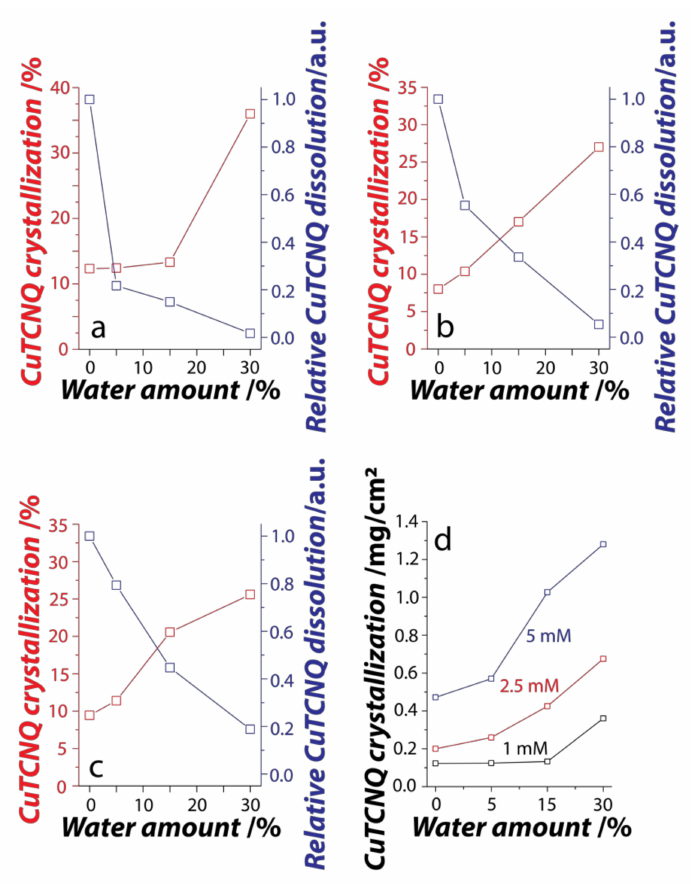
Figure 4. Crystallization and simultaneous co-dissolution of CuTCNQ in Water–DMSO bisolvent. Influence of water on CuTCNQ crystallization and corrosion at ( a ) 1 mM ( b ) 2.5 mM and ( c ) 5 mM TCNQ concentrations; ( d ) CuTCNQ crystallization on the surface of the Cu foil. % CuTCNQ crystallization in ( a – c ) refers to the proportion of TCNQ 0 reactant used during the crystallization process, while the relative CuTCNQ dissolution in ( a – c ) compares dissolution in different amounts of water with respect to that in the absence of water, where maximum dissolution is